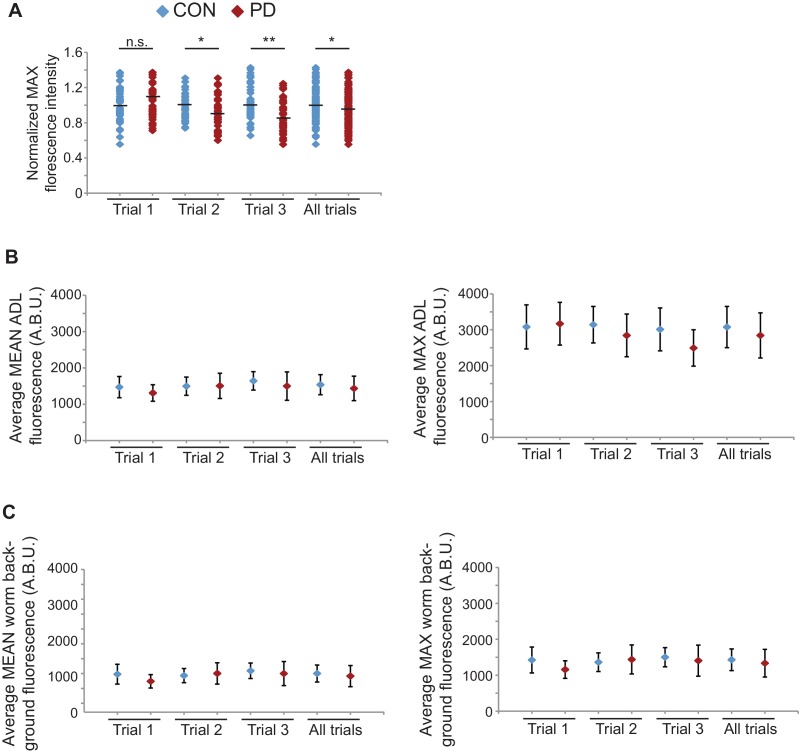
osm-9 mRNA levels quantified in mut-16(mg461) ADL neurons using smFISH.(A) Normalized maximum florescence levels in mut-16(mg461) CON and PD ADL neurons. Medians are indicated. * indicates p<0.05, ** p<10–4, n.s. not significant, Student’s t-test. (B) Graphs represent the average mean and maximum florescence levels of CON and PD ADL mut-16(mg461) neurons with osm-9 mRNA smFISH probes in arbitrary brightness units (A.B.U.). (C) Graphs represent the average mean and maximum florescence background levels of CON and PD ADL mut-16(mg461) neurons. N = 3 biologically independent trials; n ≥ 129 neurons. Error bars are standard deviation (Figure 4—figure supplement 3—source data 1).DOI:
http://dx.doi.org/10.7554/eLife.11642.03210.7554/eLife.11642.033Figure 4—figure supplement 3—source data 1.Spreadsheet containing mean and maximum florescence intensities for osm-9 smFISH probes in ADL neurons and worm backgrounds in mut-16(mg461) strain.